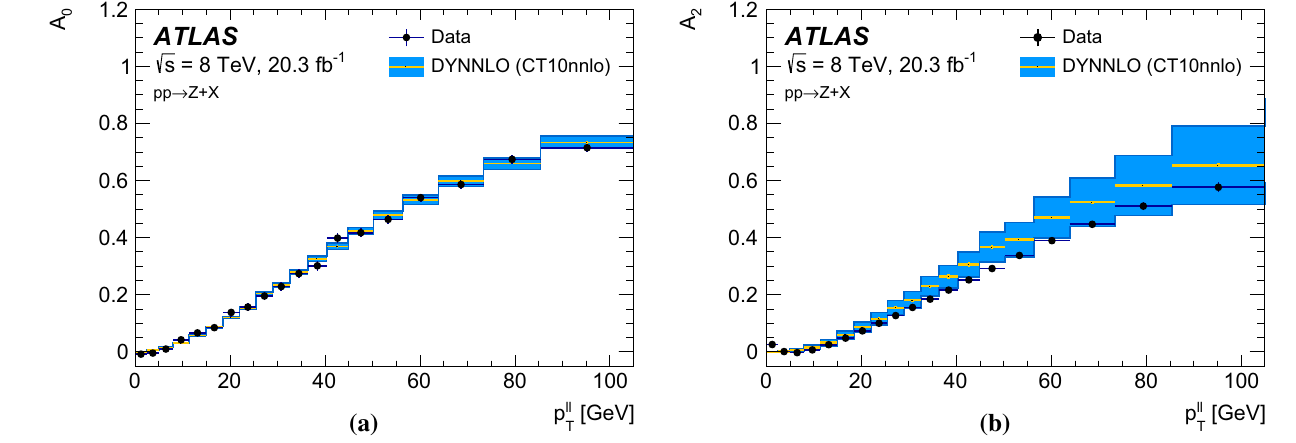
Fig. 4 The a A 0 and b A 2 angular coefficients in Z -boson events as [42]. The measured coefficients are compared to the a function of p (cid:7)(cid:7) T DYNNLOpredictionsusingtheCT10nnloPDFset.Theerrorbarsshow Table 3 Systematic uncertainties in the m W measurement due to QCD modelling, for the different kinematic distributions and W -boson charges. Except for the case of PDFs, the same uncertainties apply to W + and W − . The fixed-order PDF uncertainty given for the sepa-